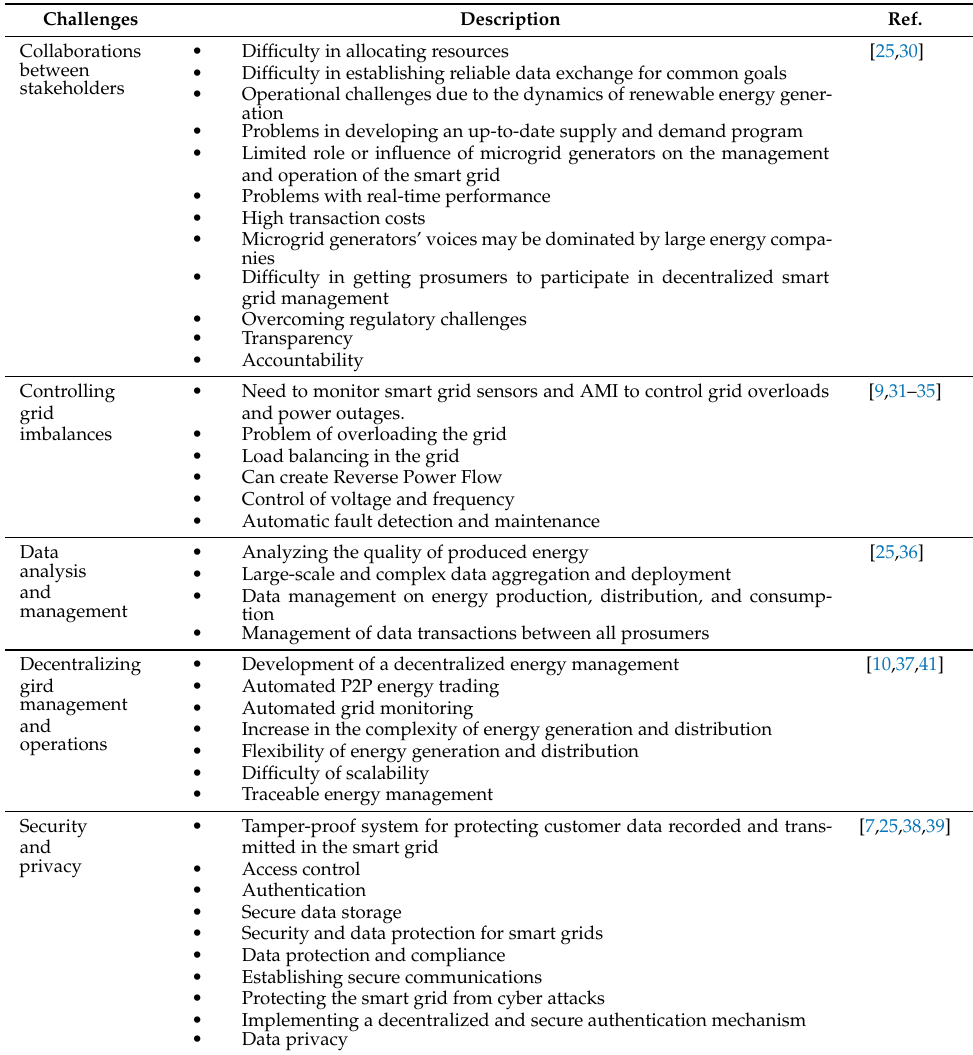
Table 1. Challenges on the current and future smart grids. Description